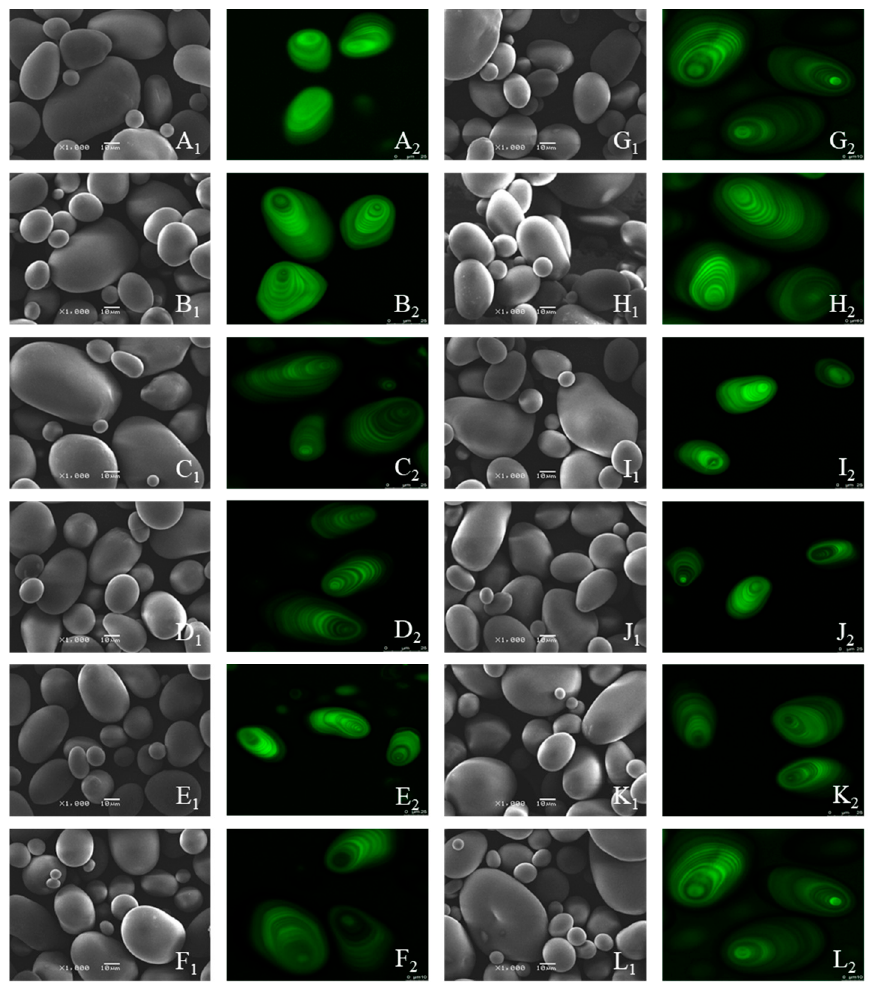
Figure 1. Scanning electron micrographs (SEM) (×1000) (1) and confocal laser scanning micrographs (CLSM) (512 × 512 pixel resolution) (2) of the native, CDH- and RDH-treated potato starch samples. A , Native; B , CDH-6; C , CDH-9; D , CDH-12; E , CDH-15; F , CDH-18; G , RDH-1; H , RDH-2; I , RDH-3; J , RDH-4; K , RDH-5; L , RDH-6.